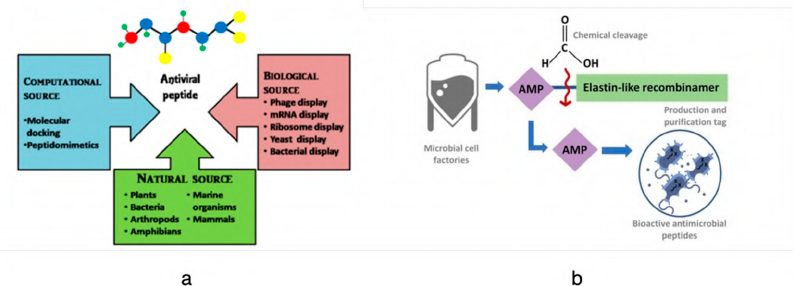
Figure 7. ( a ) Sources of antiviral peptides (reprinted with permission from Agarwal et al., 2021 [77]); ( b ) summary of recombinant antimicrobial peptide production steps. ELR is an elastin-like recom- binamer used as a fusion tag to purify the recombinant peptide in the downstream application ( reprinted with permission from Pereira et al., 2021 [78]). There are several review articles on antimicrobial peptides derived from farm ani ‐ mals and venomous animals and their mode of action and application [82,83].